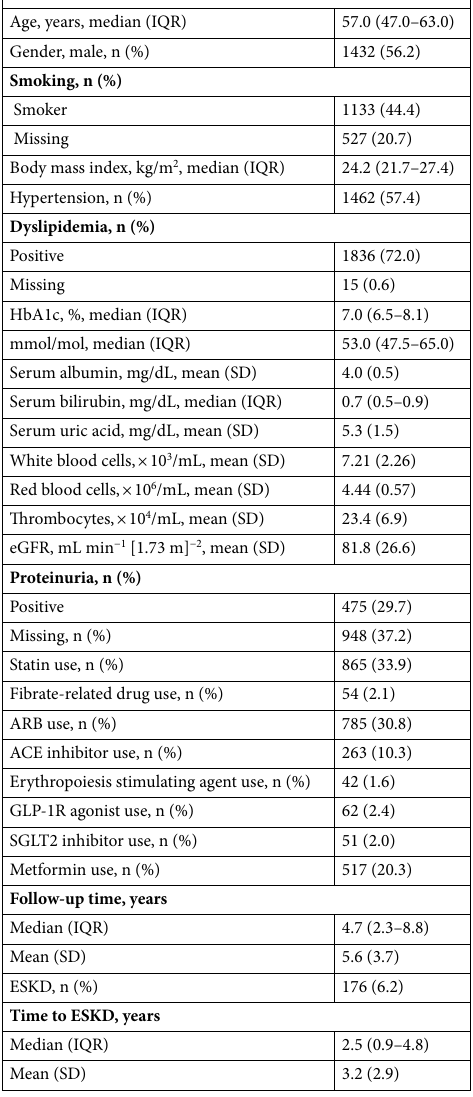
Table 1. Baseline characteristics of study subjects (n = 2549). Data are presented as the mean ± standard deviation (SD) or the median (interquartile range: IQR). HbA1c hemoglobin A1c, eGFR estimated glomerular filtration rate, ARB angiotensin II receptor blocker, ACE angiotensin converting enzyme, GLP-1R glucagon- like peptide 1 receptor, SGLT2 sodium-glucose cotransporter 2, ESKD end-stage kidney